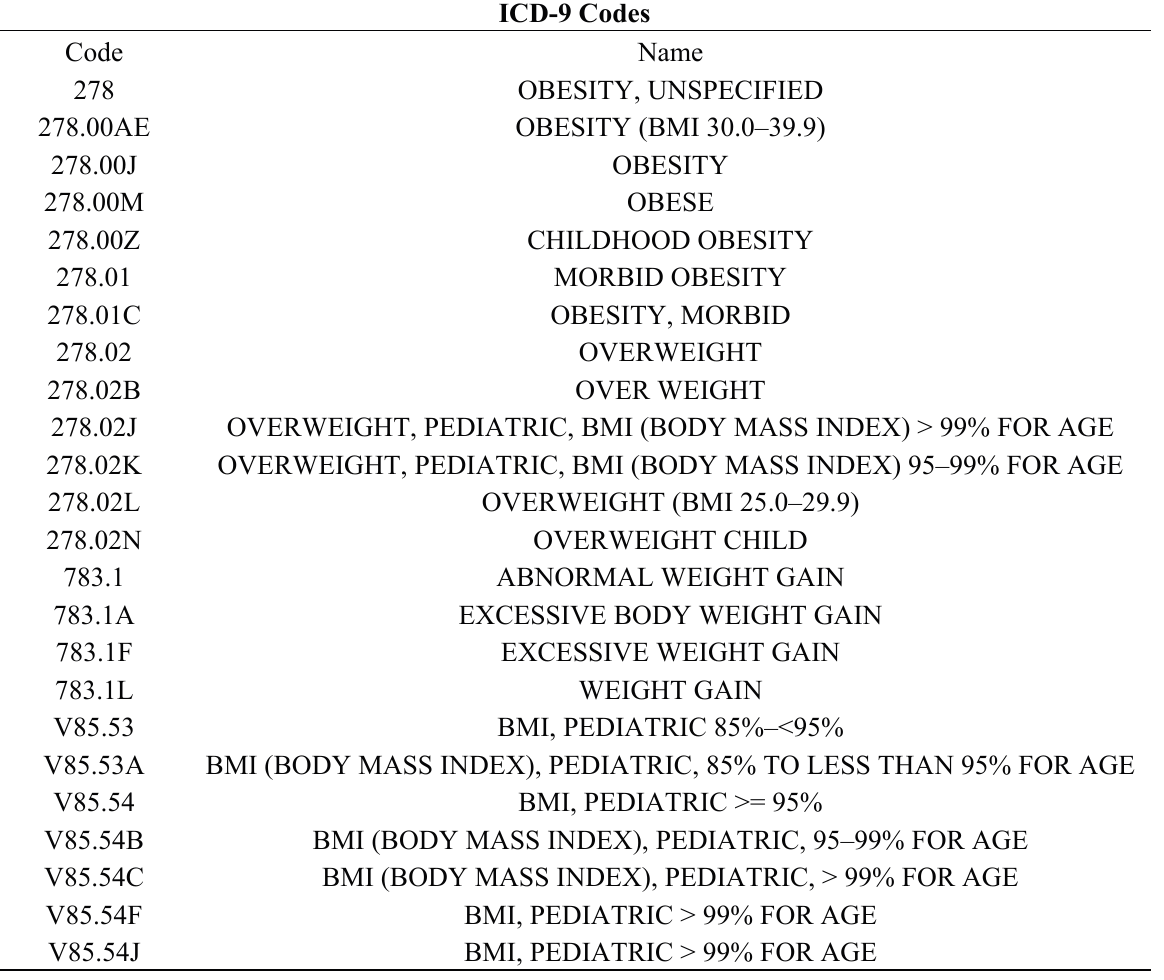
Table 1. ICD-9 Code Categorization of Qualification for Obesity Identification.